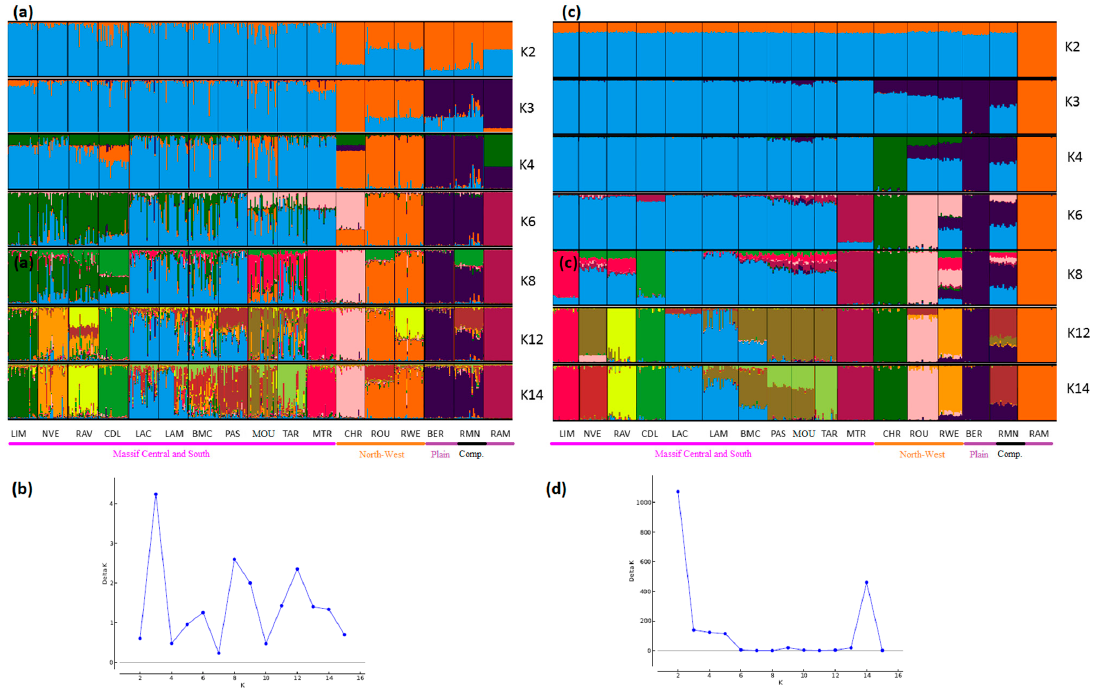
Figure 4. Genetic structure of French sheep breeds by Bayesian analysis (K = number of clusters). ( a ) STRUCTURE plot obtained from the microsatellite dataset; ( b ) graph showing ∆ K calculated according to [42] for the microsatellite dataset; ( c ) STRUCTURE plot obtained from the SNP dataset; ( d ) graph showing ∆ K calculated according to [42] for the SNP dataset. Comp.: composite breeds; information concerning the region of origin of each breed was extracted from [21]; for breed names see codes in Table S1.